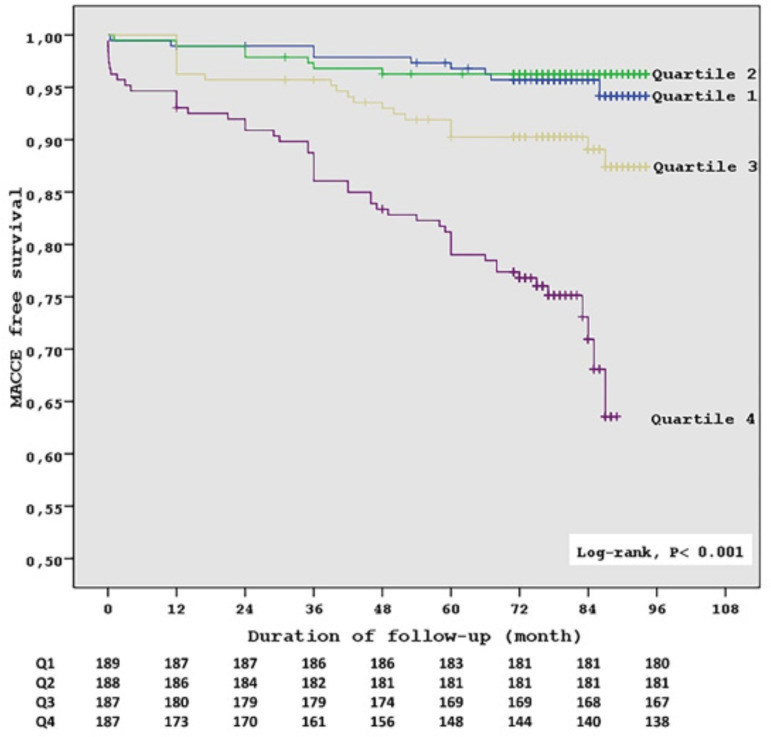
Kaplan-Meier estimates of survival free of cardiovascular death, stroke, myocardial infarction and repeated coronary revascularization (P<0.001 by the log-rank test). Q=quartile